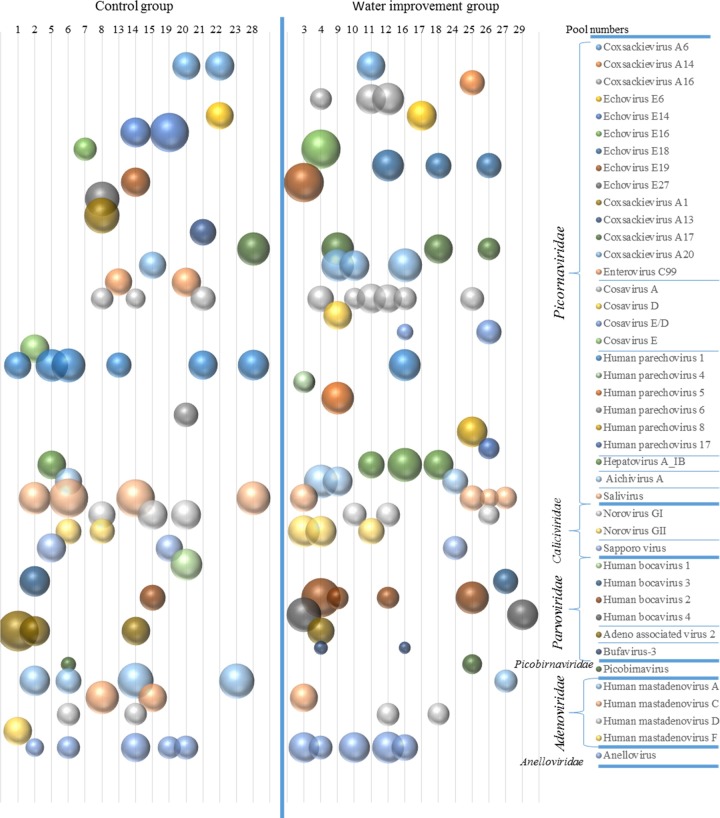
Distribution of viral sequences reads to named viruses using BLASTx E score <10−10.